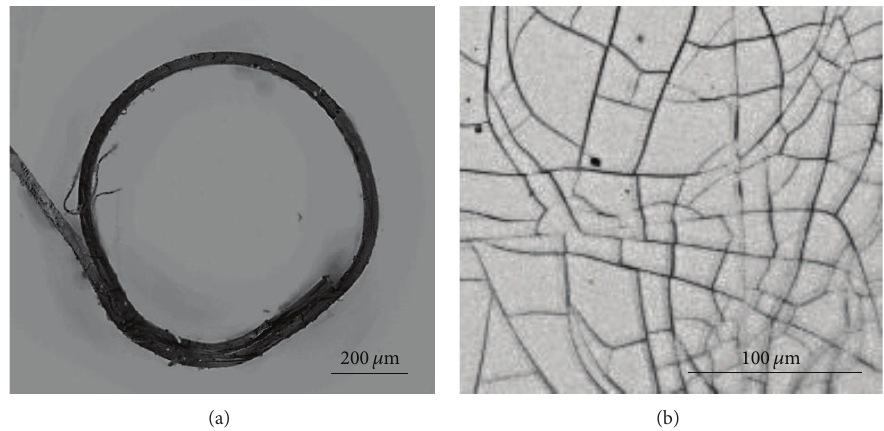
Figure 2: (a) An optical micrograph of cross section of the rolled PDMS bilayer. (b) An optical micrograph of cracks generated on the surface of the oxidized PDMS layer.